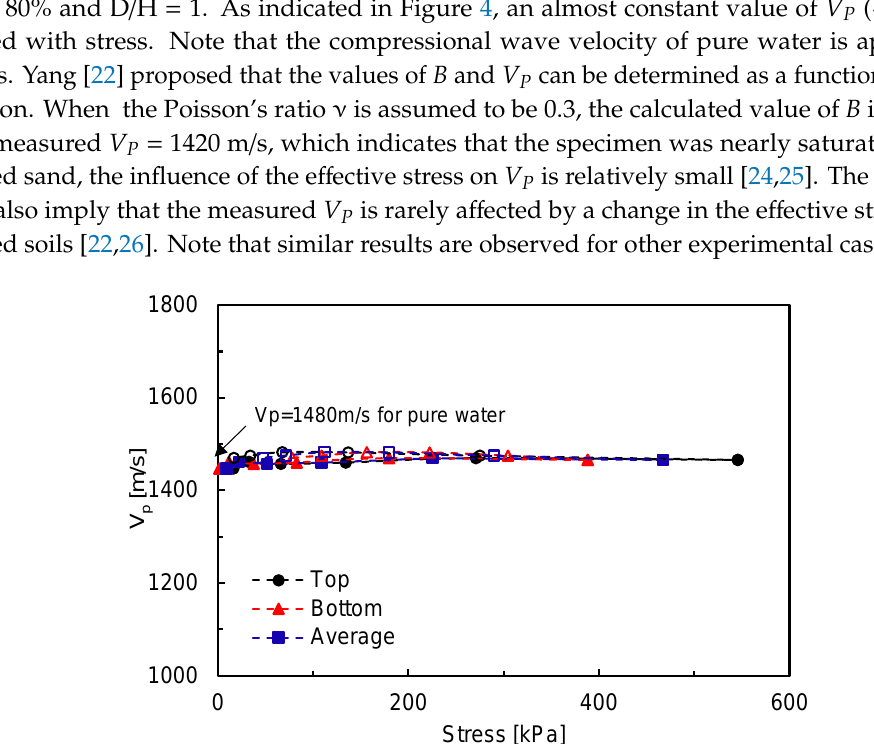
Figure 4. Evolution of compressional wave velocity along applied stresses for Dr = 80% and D / H = 1. Solid and hollow markers denote the loading and unloading steps, respectively.